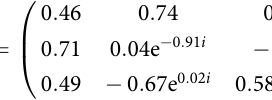
computed for a [111] fi eld of magnitude h (cid:6) h crit